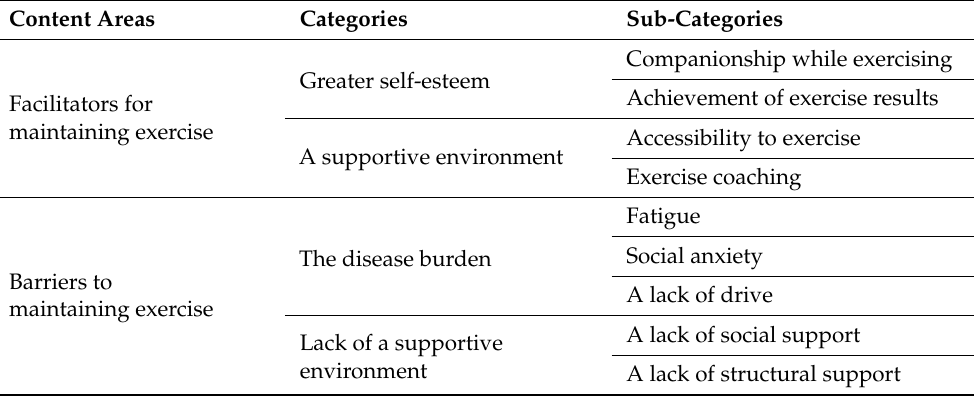
Table 2. Content areas, categories, and sub-categories exploring adolescents ´ experiences of facilita- tors for and barriers to maintaining exercise after a group-based intervention for